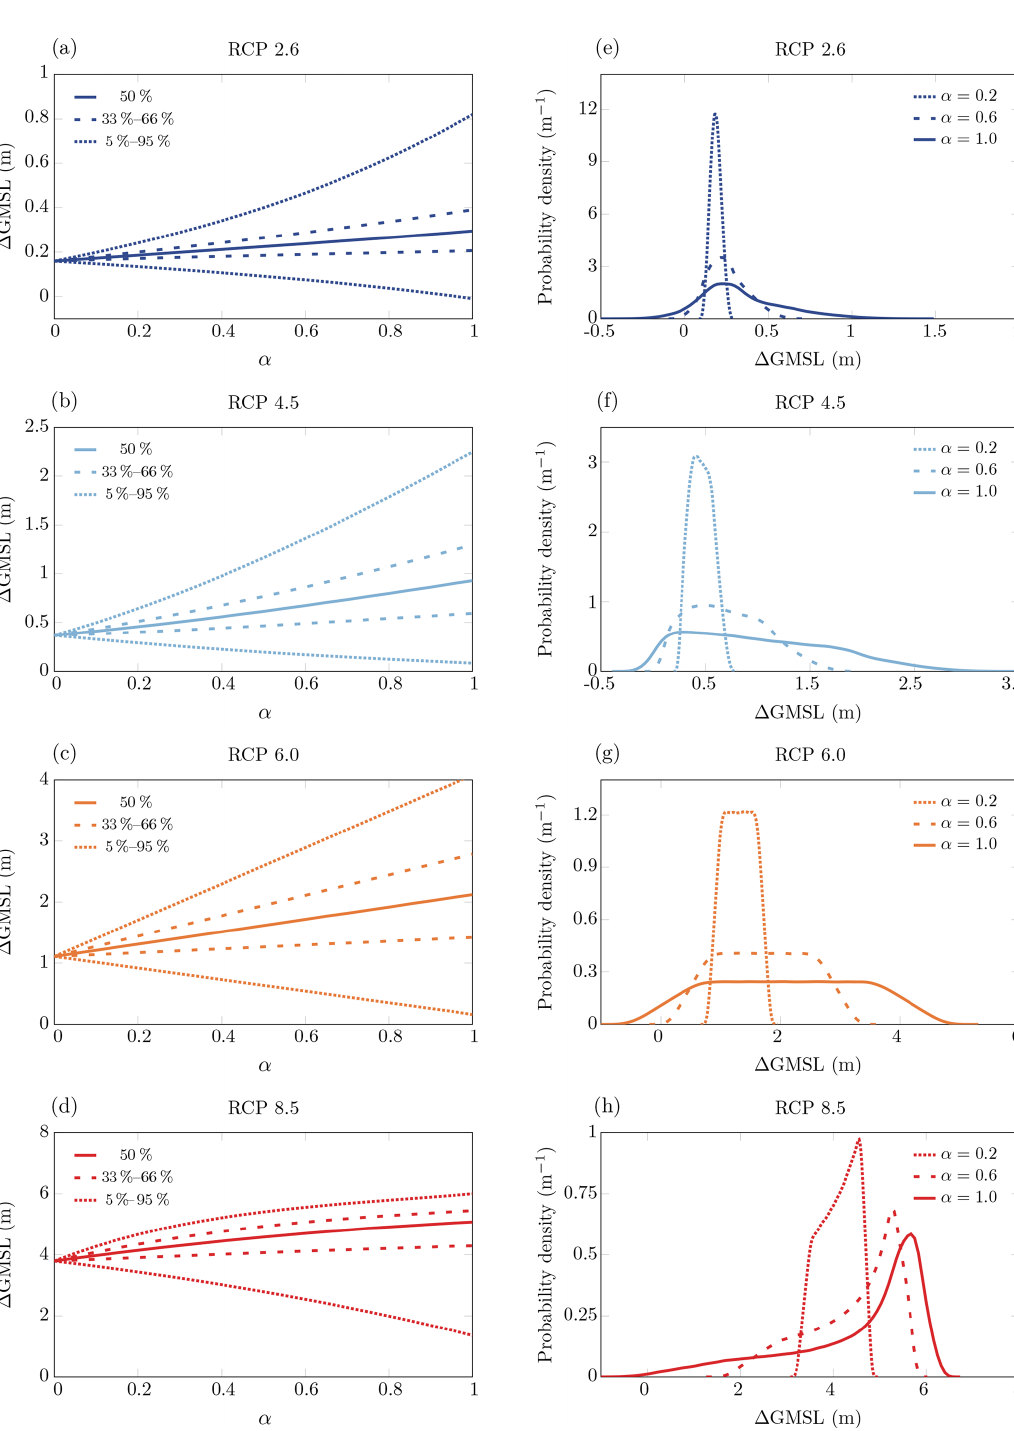
Figure 11. Robustness of probabilistic projections with respect to the scaling factor α . Median projections and their 33%–66% and 5%– 95% probability intervals by 3000 under for the weakly non-linear sliding law in (a) RCP 2.6, (b) RCP 4.5, (c) RCP 6.0 and (d) RCP 8.5. Probability density functions for α = 0 . 2 (dotted lines), α = 0 . 6 (dashed lines) and α = 1 (solid lines) in (e) RCP 2.6, ( f ) RCP 4.5, (g) RCP 6.0 and (h) RCP